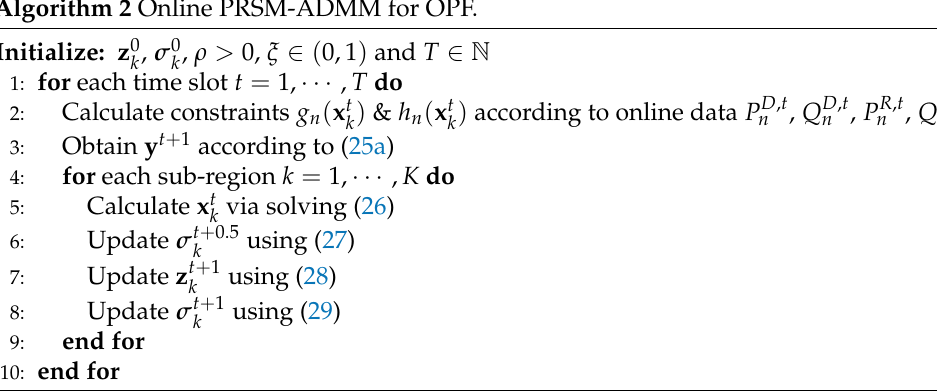
Algorithm 2 Online PRSM-ADMM for